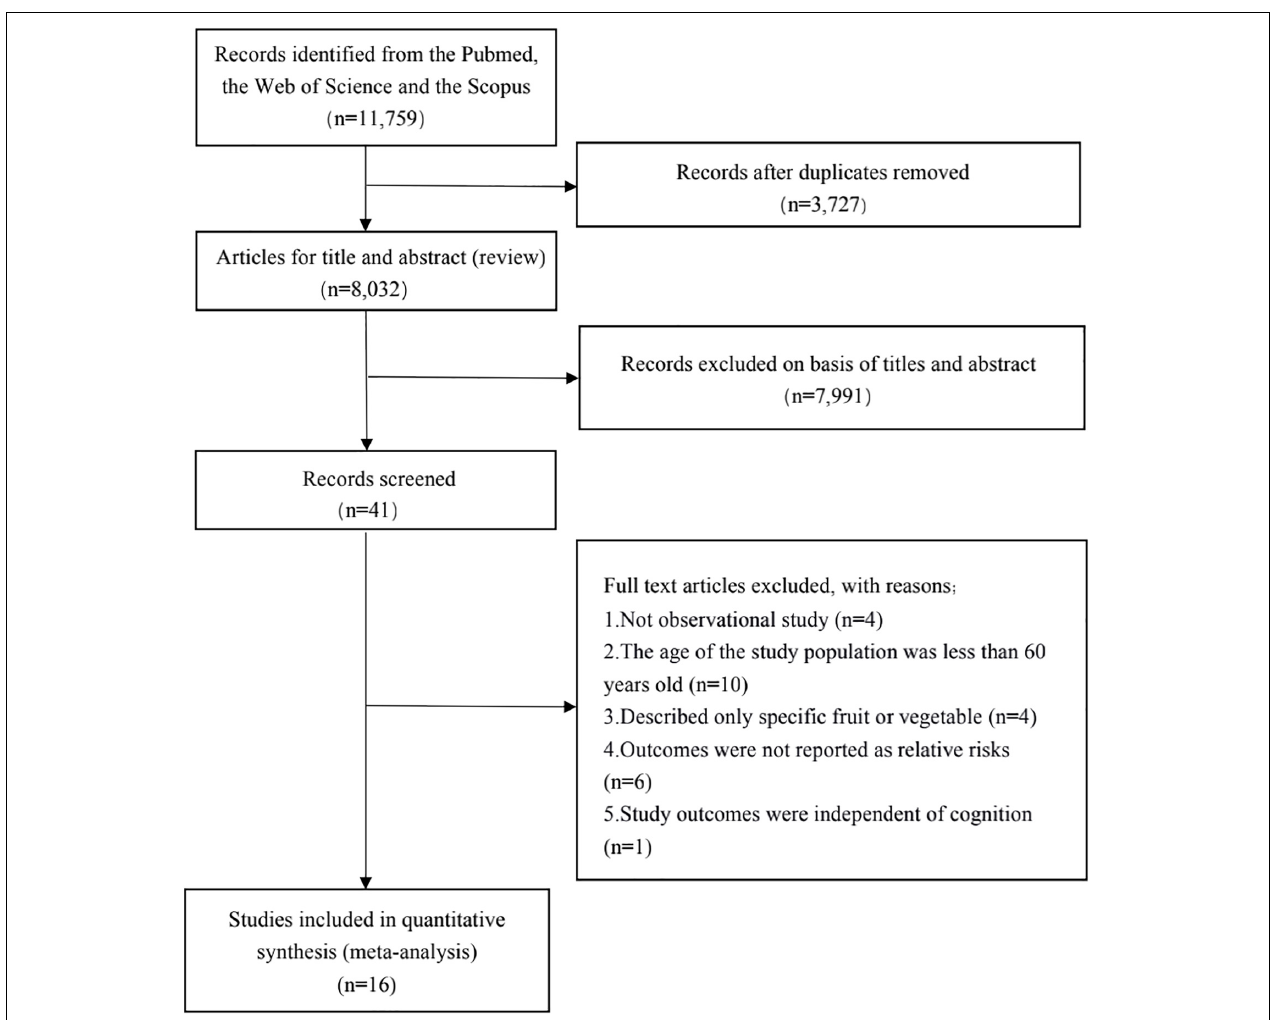
FIGURE 1 | Flowchart of study selection about the relationship between fruits and vegetables intake and cognitive